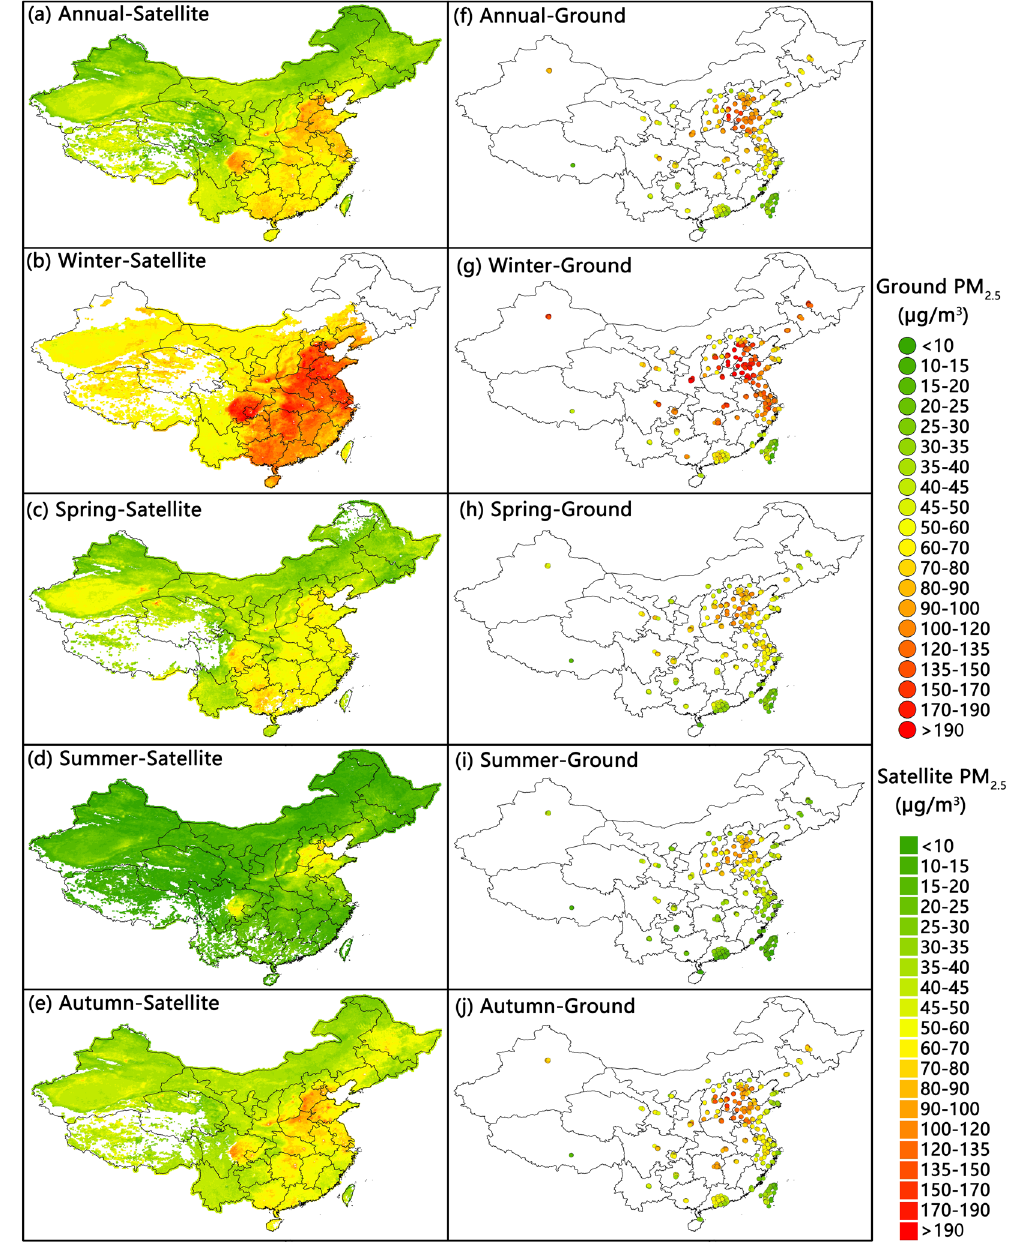
Figure 5. Seasonal and annual distributions of PM 2.5 concentrations estimated using the Bayesian Gaussian process model. This map was generated using ArcGIS 9.3 26 based on our Gaussian processes estimated PM 2.5 data (left column) and the ground-level PM 2.5 measurements (right